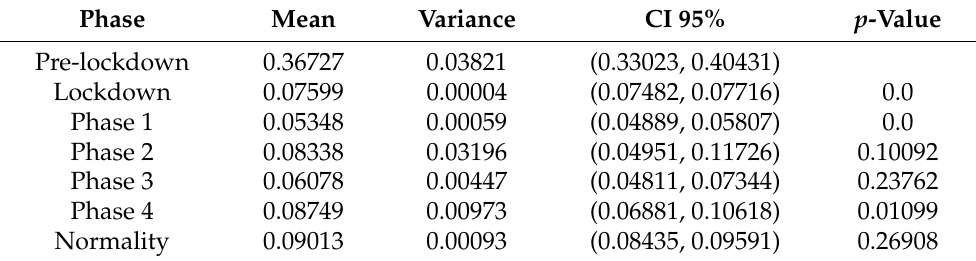
Figure 3. A distribution of the values for β for the different stages of lockdown in the different provinces of Italy. Table 1. Statistics for the Italian Histogram